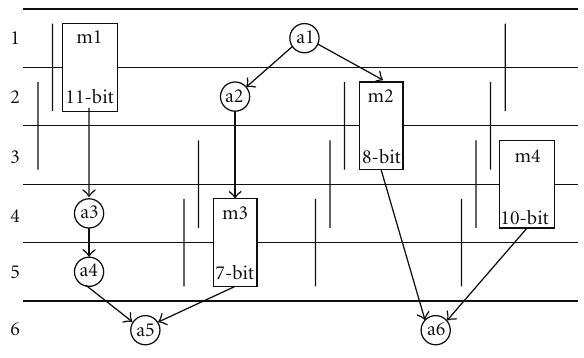
Figure 3: Application DFG showing alternative scheduling possibilities meeting timing constraints for the multiplications (no resource constraint).